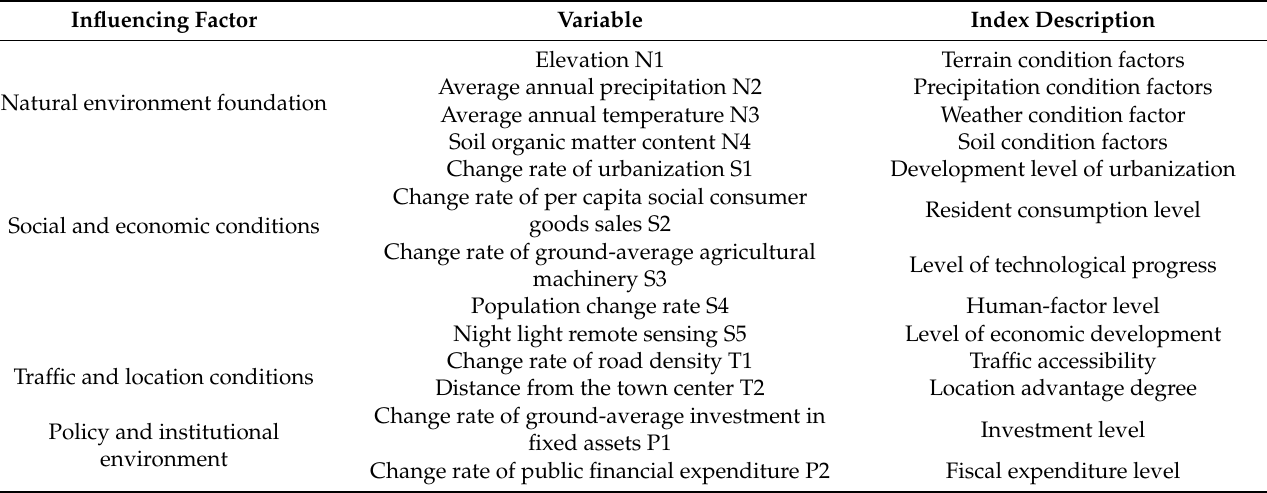
Table 2. Land use change influencing factors